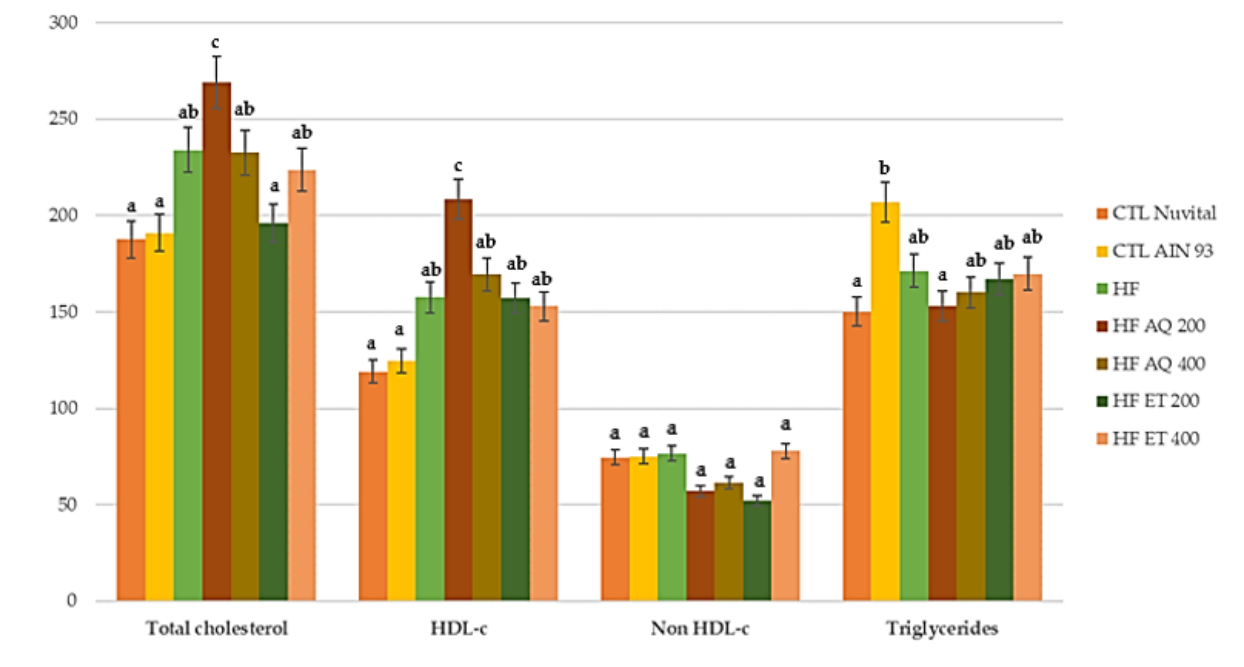
Figure 5. Total cholesterol, fractions and triglycerides (mg/dL) of animals fed a balanced or high-fat diet and supplemented with saline, aqueous extract or ethanol extract of G. gardneriana leaves per day for 8 consecutive weeks. Values expressed as mean ± standard deviation. Different letters indicate a significant difference between groups and groups with the same letter are not significantly different. p < 0.001; n = 6 – 11; ANOVA followed by Tukey post-test.